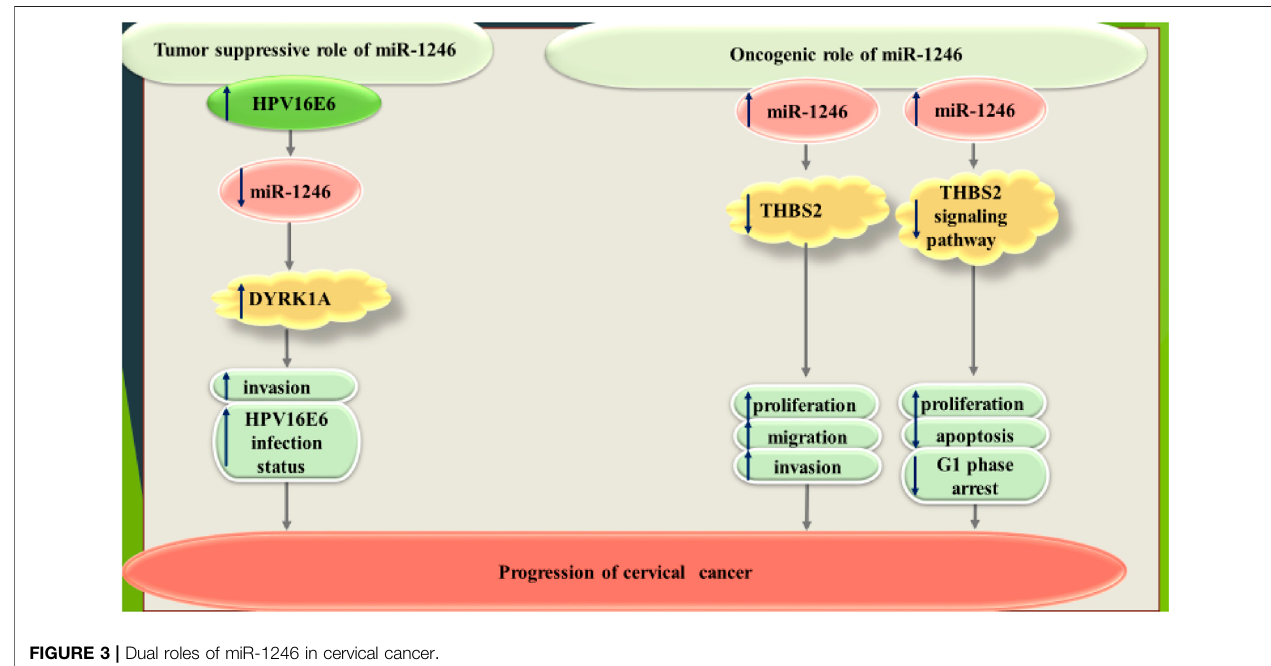
FIGURE 3 | Dual roles of miR-1246 in cervical cancer.